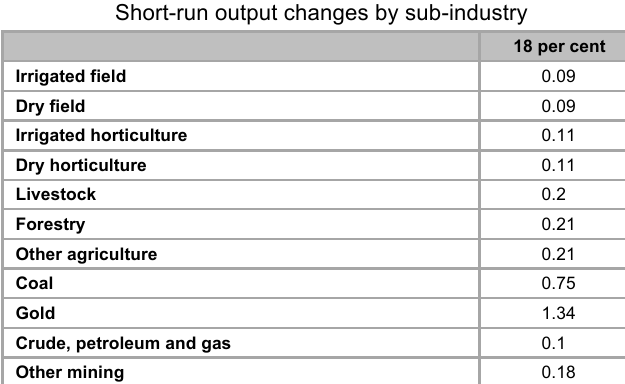
Short-run output changes by sub-industry